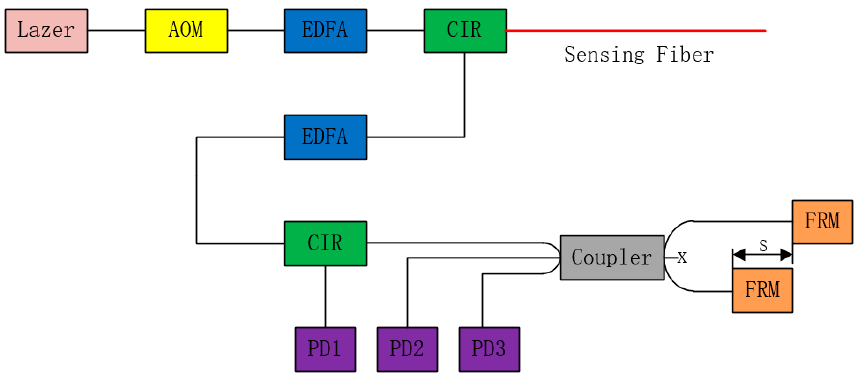
Figure 3. The experimental setup of the DAS system.